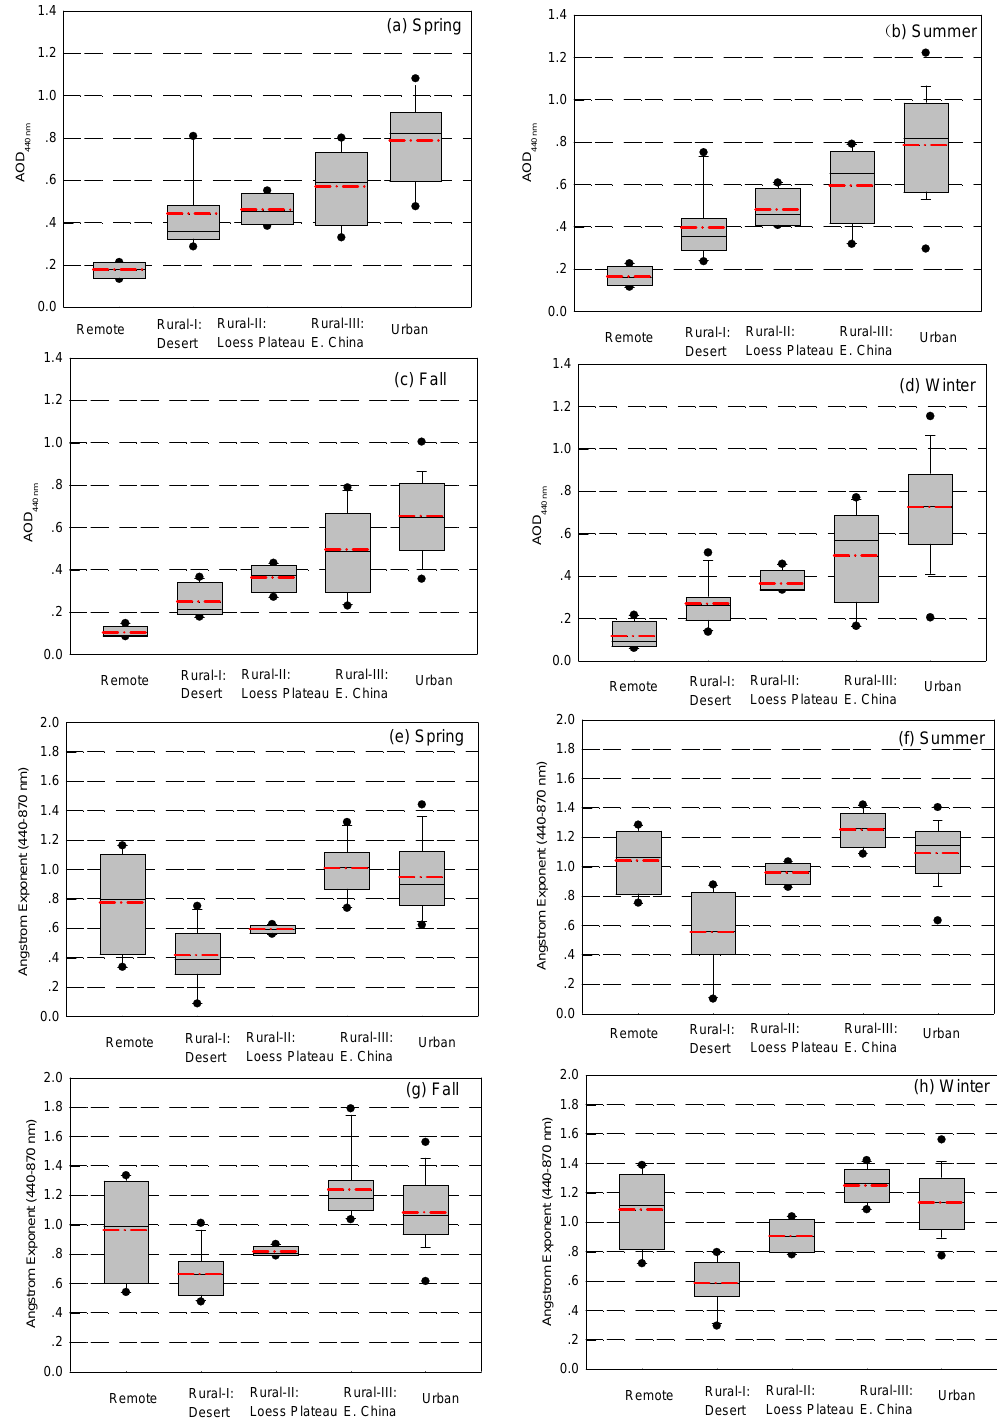
Figure 5. Seasonally averaged AODs at 440nm ( a – d ) and AEs between 440 and 870nm ( e – h ) at remote, rural, and urban regions of